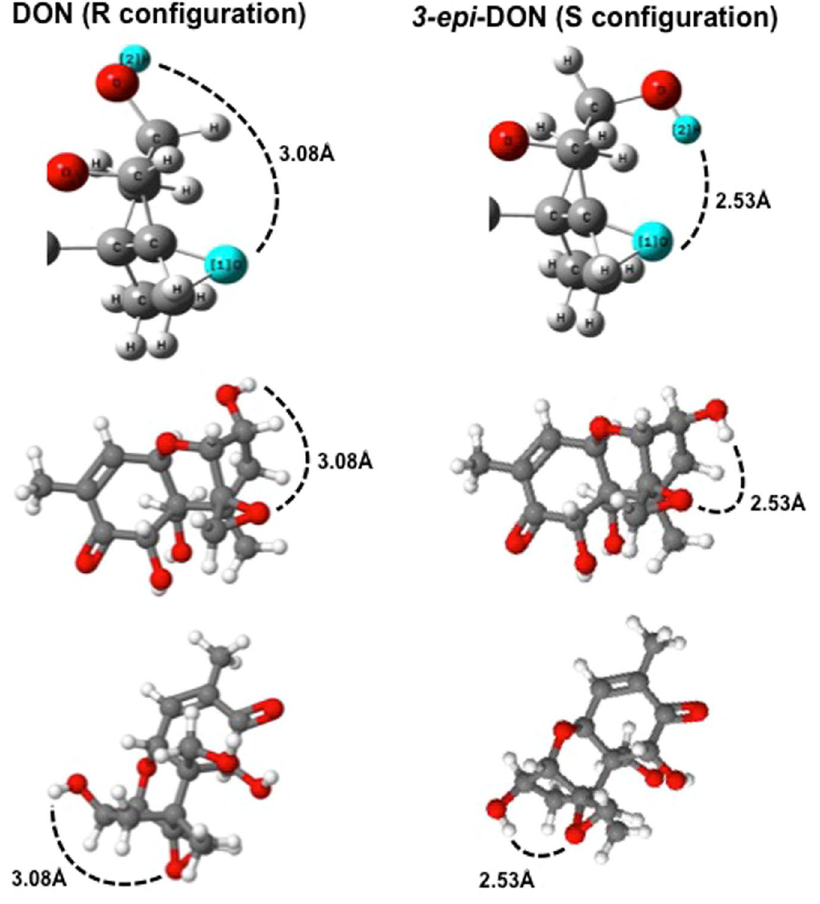
Figure 7. Molecular modeling of DON and 3-epi- DON. The molecular modeling of DON ( right panel ) and 3-epi- DON ( left panel ) chemical structures was achieved by Hyperchem 8.0. The decreased distance between the hydrogen atom of the C3 hydroxyl group and the oxygen atom of the epoxide group in 3-epi- DON (2.5 Å) in comparison to DON (3.1 Å) suggests the possibility of an intramolecular hydrogen bond formation that contributes to 3-epi- DON stability and influences its ribosomal binding capacity 28